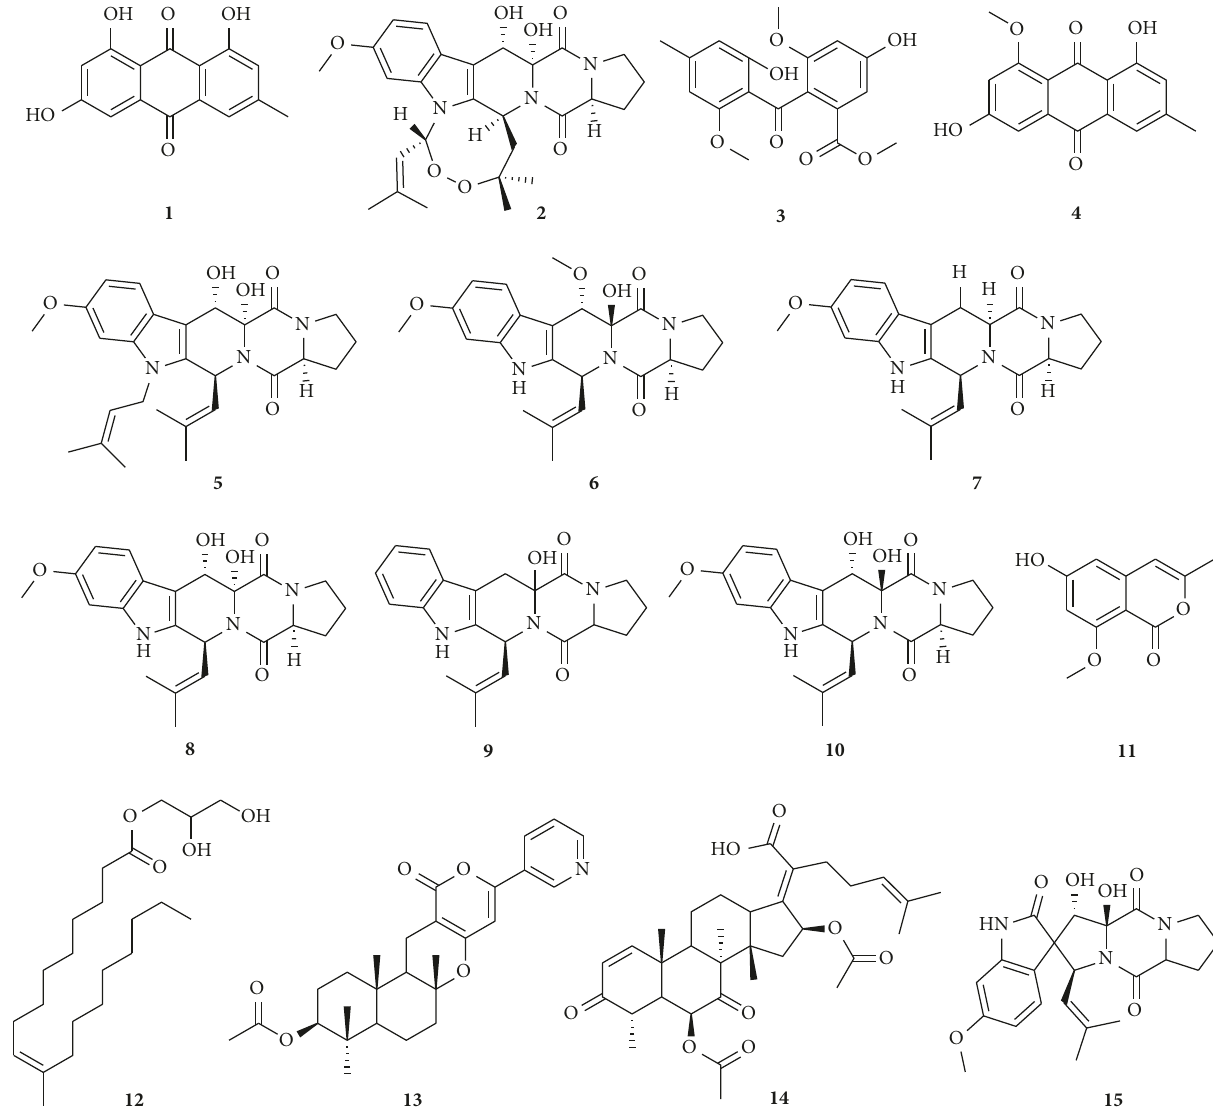
Figure 4: Chemical structure of compounds